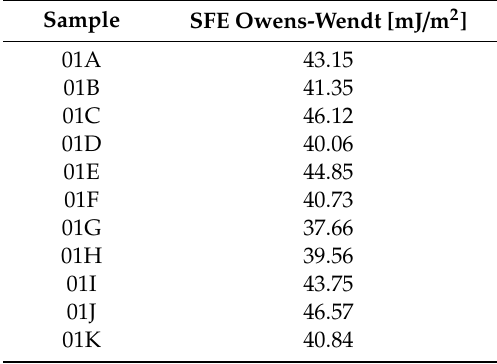
Table 9. Surface free energy values of Al 2 O 3 coatings without thermo-chemical